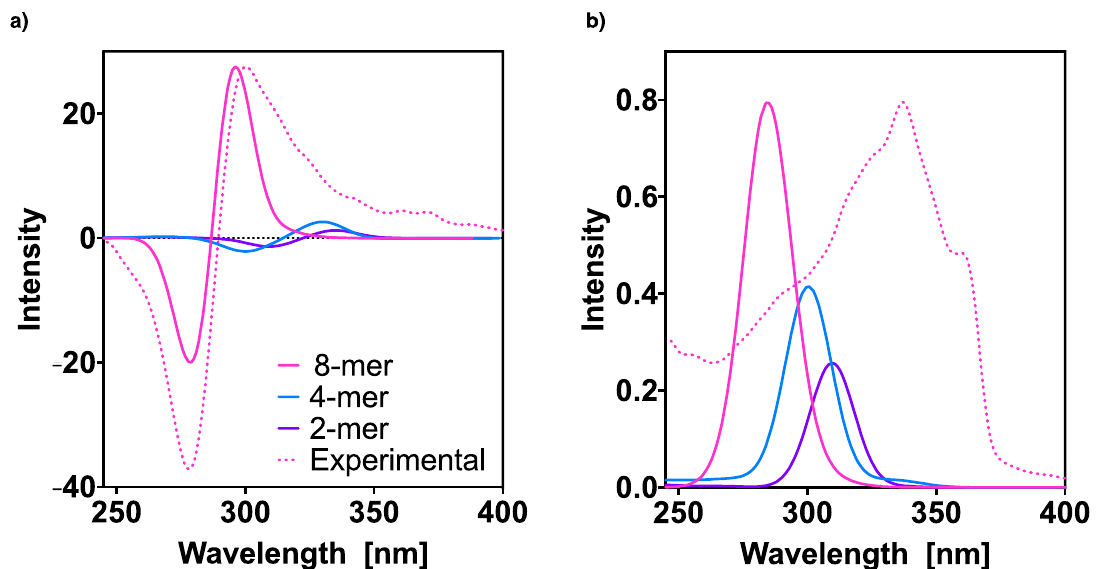
Figure 6. Effect of the aggregation on the TD-DFT (CAM-B3LYP)/3–21G ( a ) ECD and ( b ) UV-Vis spectra of oligo(phenyleneethynylene) (OPE) ( S )- 1 hh n-mers, n = 2, 4, and 8. The corresponding experimental spectra are included for comparison. No correction factors are considered in the theoretical wavelengths. The 8-mer intensities were normalized with respect to the experimental ones and the 2,4-mer intensities scaled with the same factors.